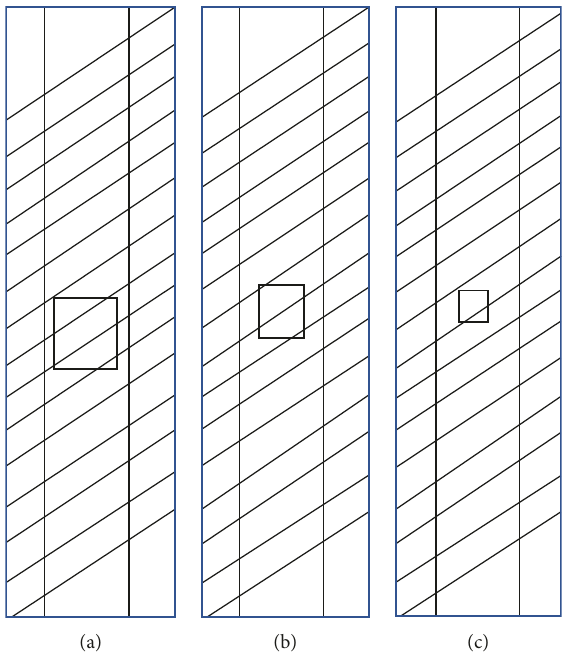
Figure 6: Schematic of defect location. (a) 18-inch cube, (b) 15- inch cube, and (c) 10-inch cube.